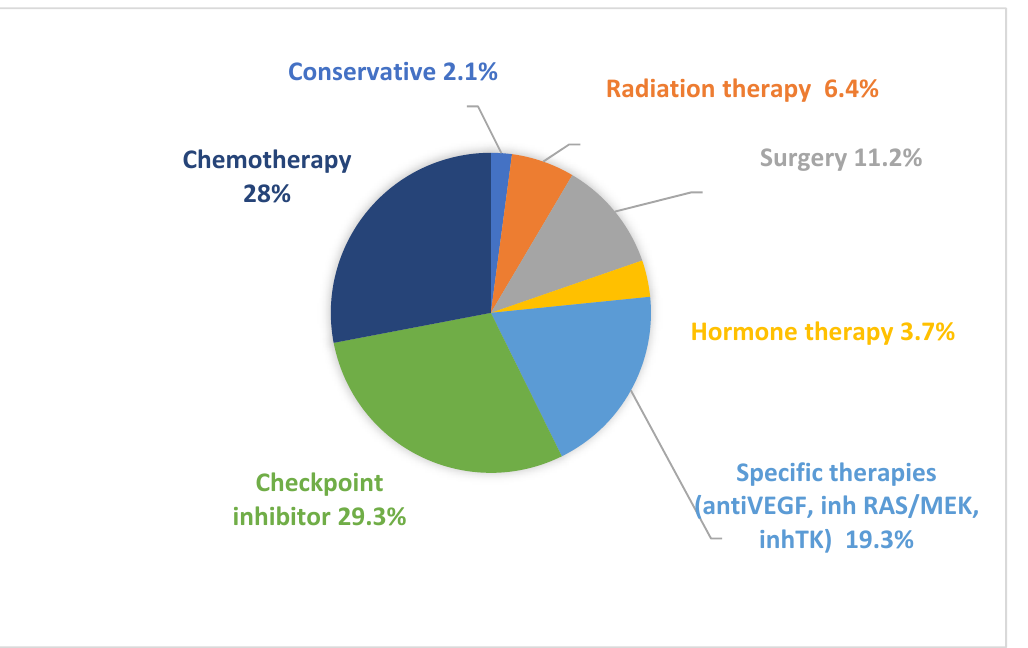
Figure 1. Oncospecific treatment prior to kidney biopsy. Types of treatments received by patients before undergoing kidney biopsy.